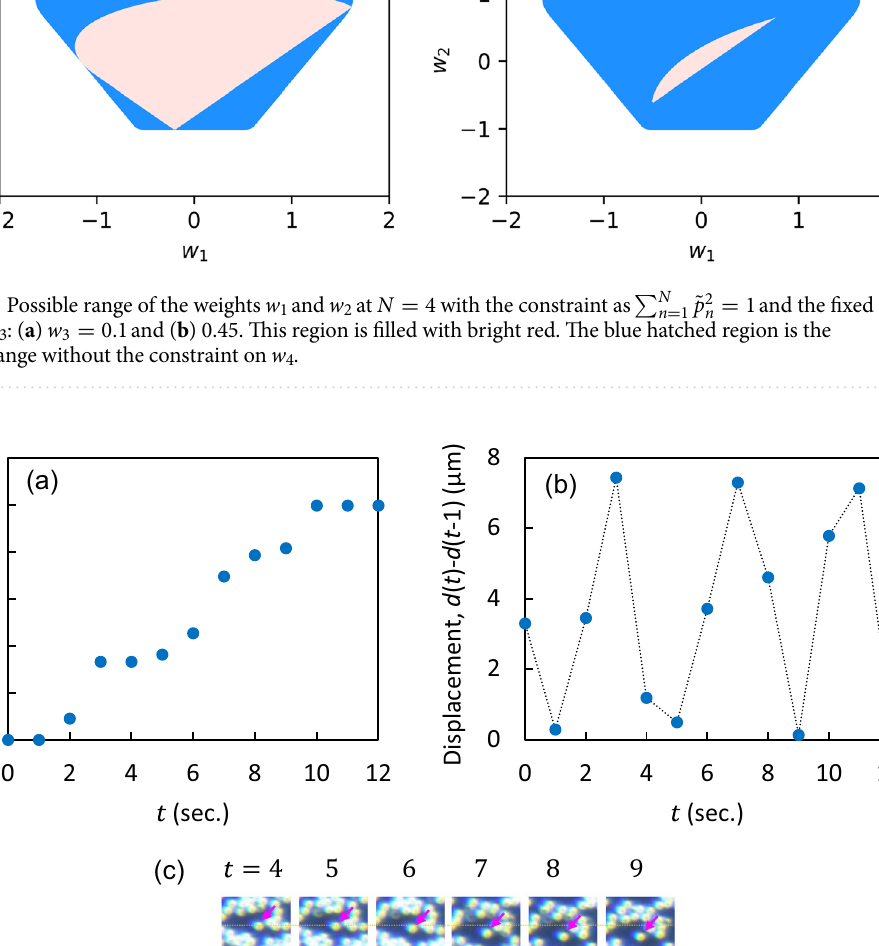
Figure 6. ( a ) Deviation of the position of a certain particle with respect to the reference position at t = 0 . The displacement is measured from the optical microscope images. ( b ) Mean displacement every 1 s for 30 particles. ( c ) Snapshots of the particle motion in ( a ) for several seconds. Orange dashed line indicates the position at t = 4 s. The particle of interest is indicated by the pink